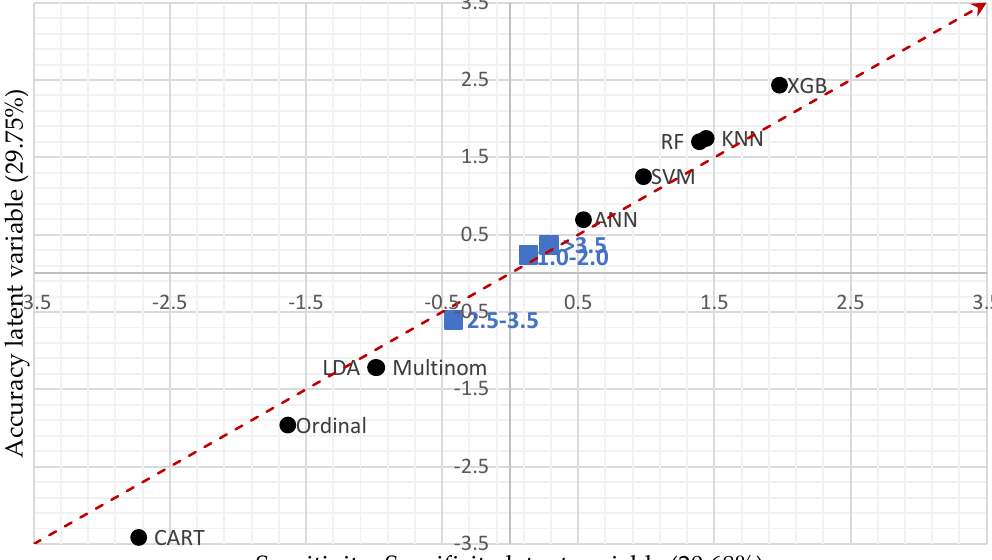
Figure 5. A plot of the accuracy and sensitivity–specificity latent variables from their first dimension/component obtained through a factor analysis of mixed variables (a combination of principle component and multiple correspondence analyses) procedure on measures of performance for the prediction of ewe BCS at weaning. Dots (red sphere: model, blue square: BCS class). Dotted diagonal line indicates a balance between accuracy and sensitivity–specificity. If dot is above, then model or BCS class was more accurate than sensitive–specific while the reverse indicates that the model was more sensitive than accurate. The further and more positive a model is along the diagonal line, the greater and better is its prediction power. The variance explained by each extracted first dimension for each latent variable (accuracy, sensitivity–specificity) is given in parenthesis along the axes.